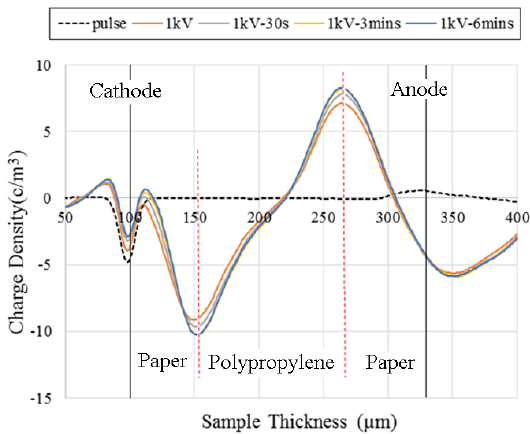
Figure 30. Space charge distribution in PPLP film under 1 kV applied voltage (Volt ‐ on).